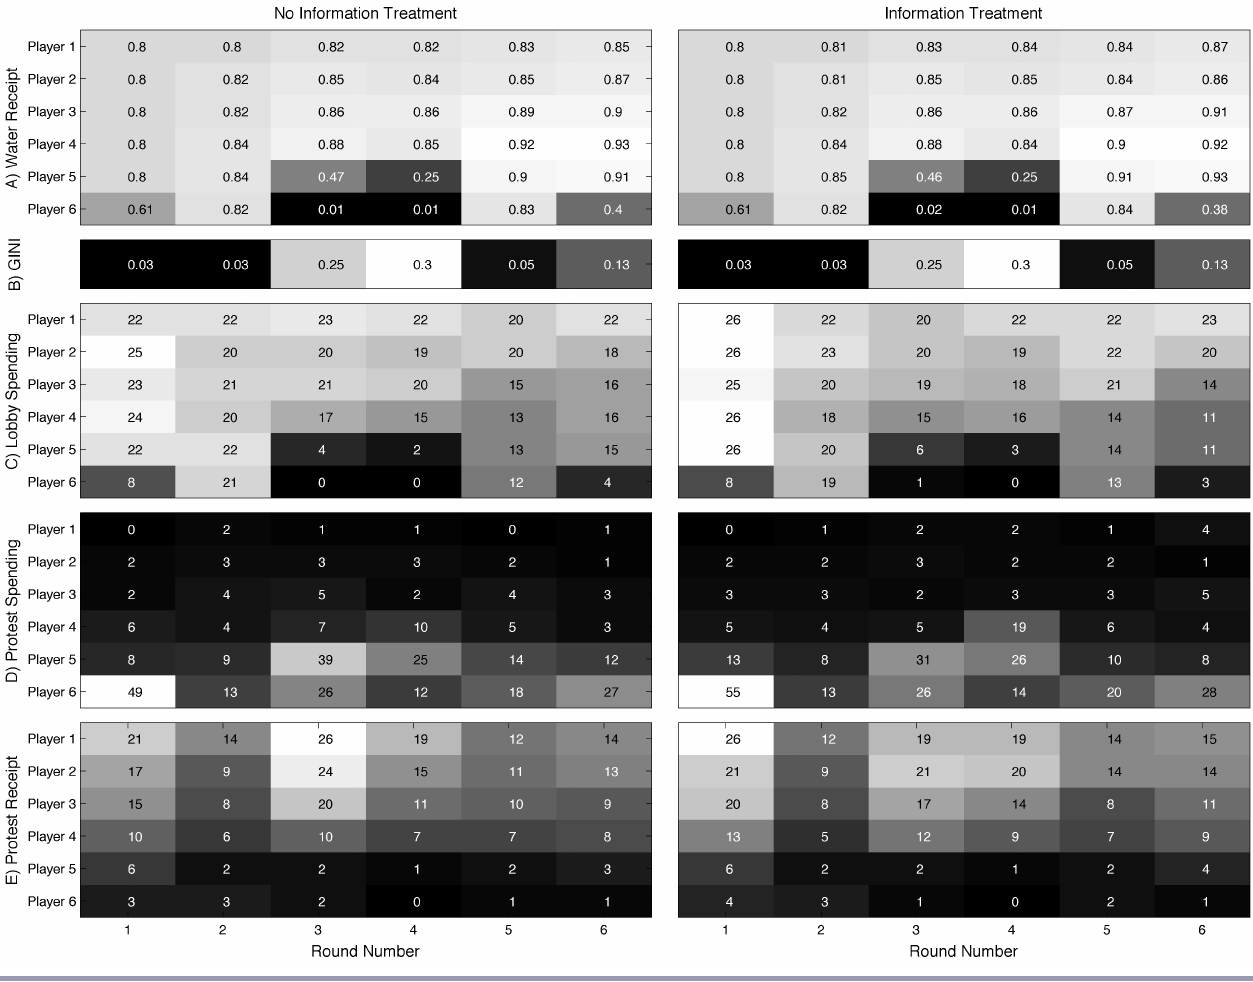
Fig. 9 . Game outcomes and actions: (A) water receipt, (B) Gini coefficient for water receipt, (C) lobby spending, (D) protest spending, and (E) protest